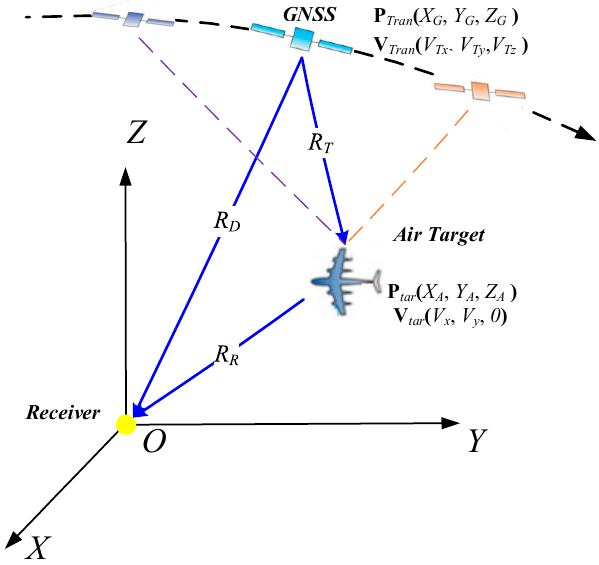
Figure 1. Air target detection geometric configuration with global navigation satellite system (GNSS) illuminators.